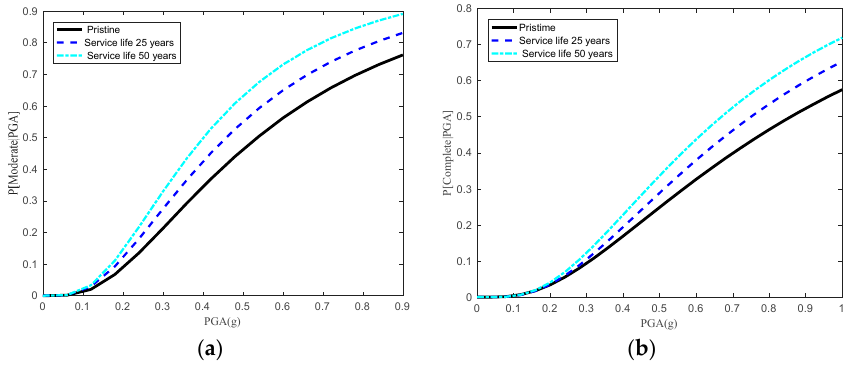
Figure 15. Time-dependent system seismic fragility curves for an MSC concrete girder bridge for ( a ) a moderate damage state and ( b ) a complete damage state under multi-deterioration of multiple components.